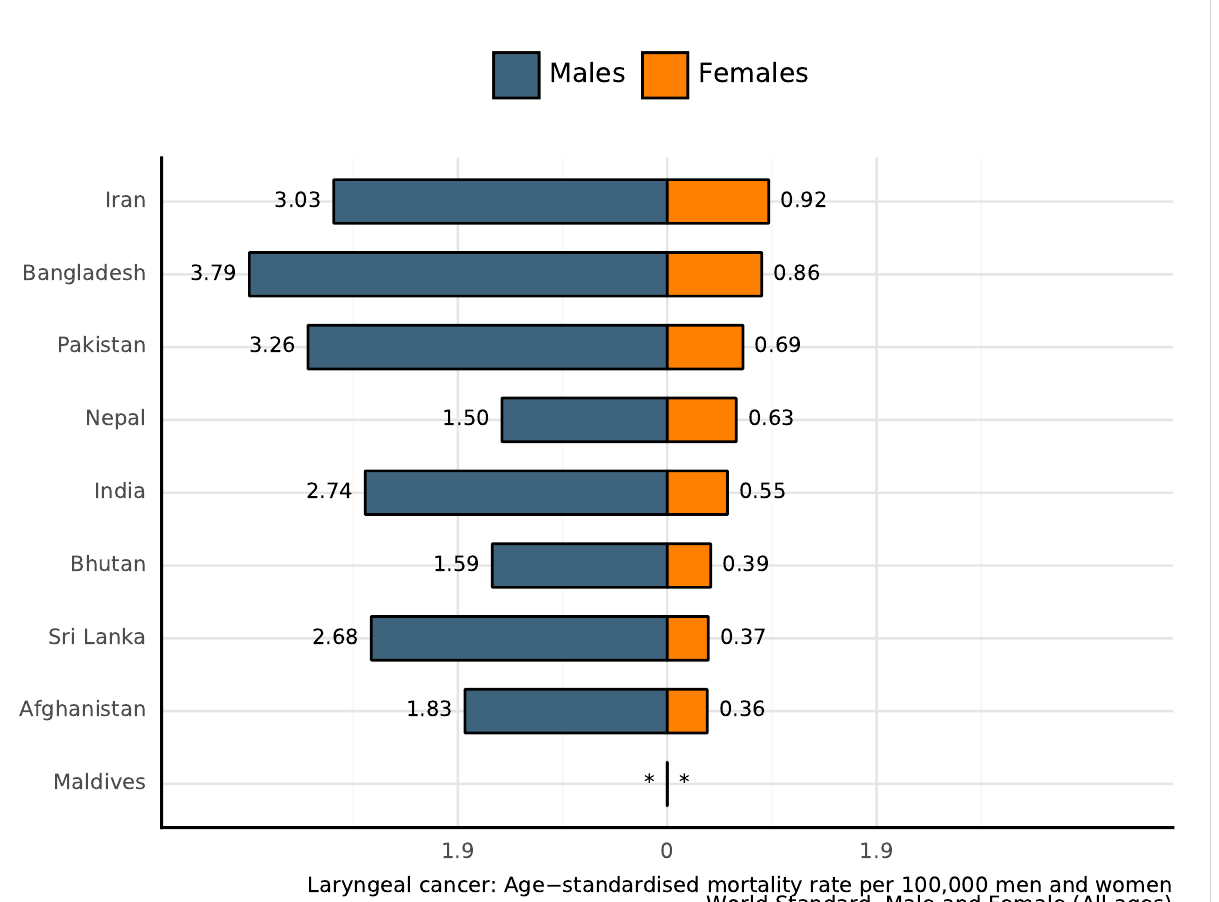
0 1.9 Laryngeal cancer: Age standardised mortality rate per 100,000 men and women World Standard. Male and Female